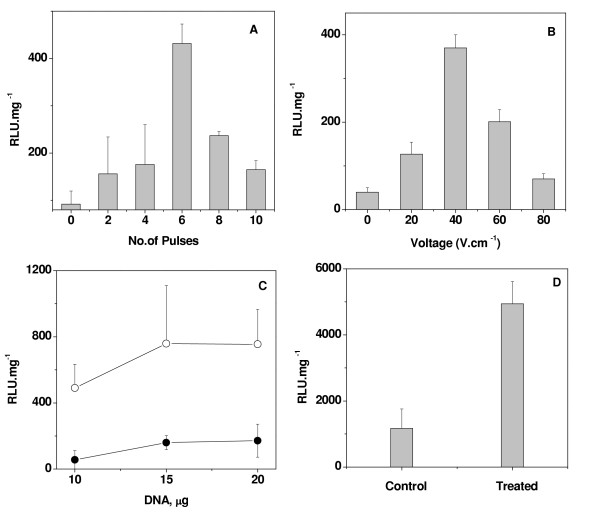
Influence of various parameters of electroporation on reporter gene activities in adult zebrafish and Indian Carp. Electrical pulses were applied following intra-muscular injection of plasmid DNA: A, Pulse number; B, Voltage strength; C, Amount of plasmid DNA present in fixed volume with (open circles) and without (closed circles) electroporation. D, Effect of electroporation (40 V·cm-1 and 6 pulses) on 2–3 month old Indian carp. Controls received only the plasmid in injection. Relative luminescence units were normalized for the amount of protein. Each data point is an average of values obtained from 6–8 fish and each experiment was repeated three times.